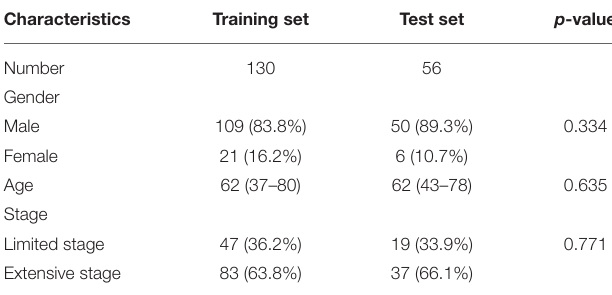
TABLE 1 | Clinical